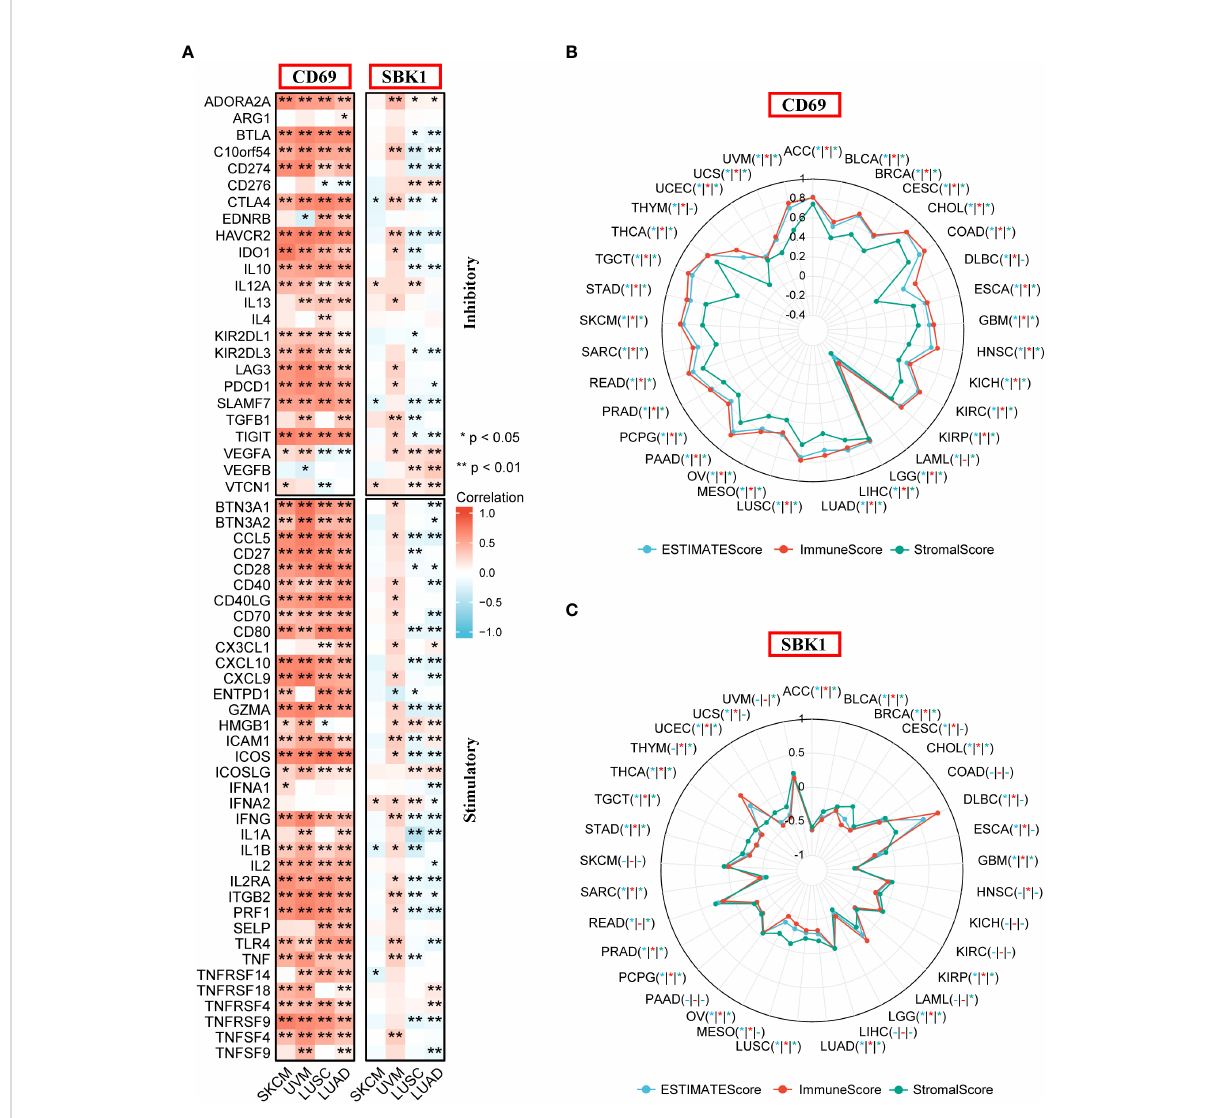
FIGURE 5 Analysis of the correlation between CD69 and SBK1 expression levels and immune checkpoints and ESTIMATE score. (A) Correlation between immune checkpoints and the expression levels of CD69 and SBK1 in Lung Cancer and Melanoma related TCGA cohorts. (B, C) ESTIMATE analysis of CD69 (B) and SBK1 (C) in TCGA tumors. – indicates not signi fi cant. * indicates p<0.05. ** indicates